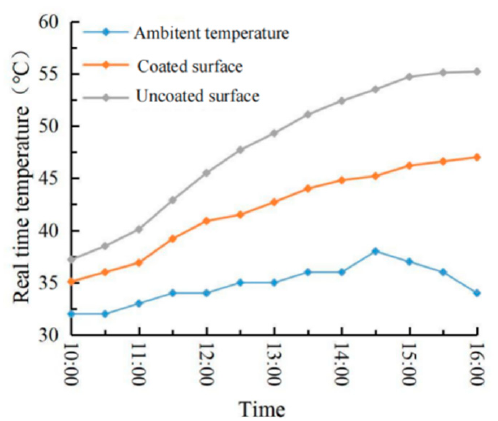
Figure 17. Real-time temperature chart.